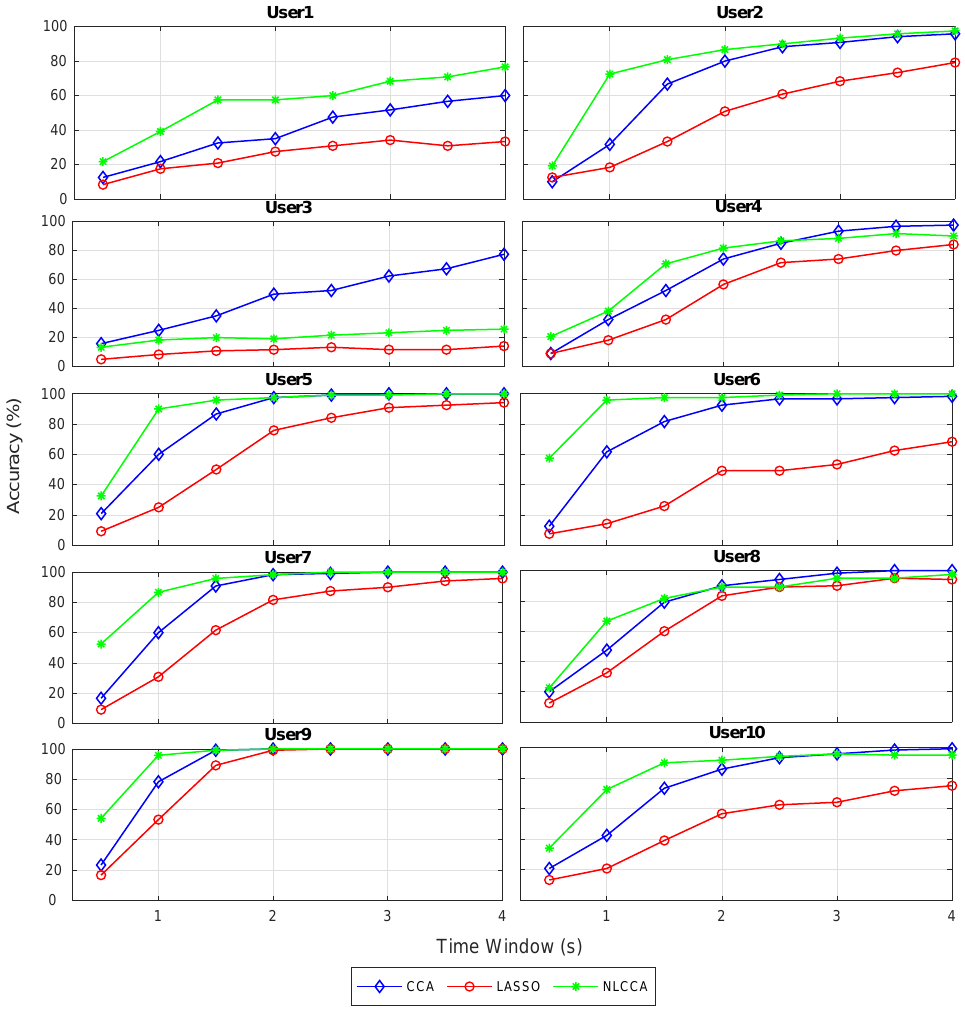
Figure 5. Comparison of accuracy for each subject between CCA, LASSO, and